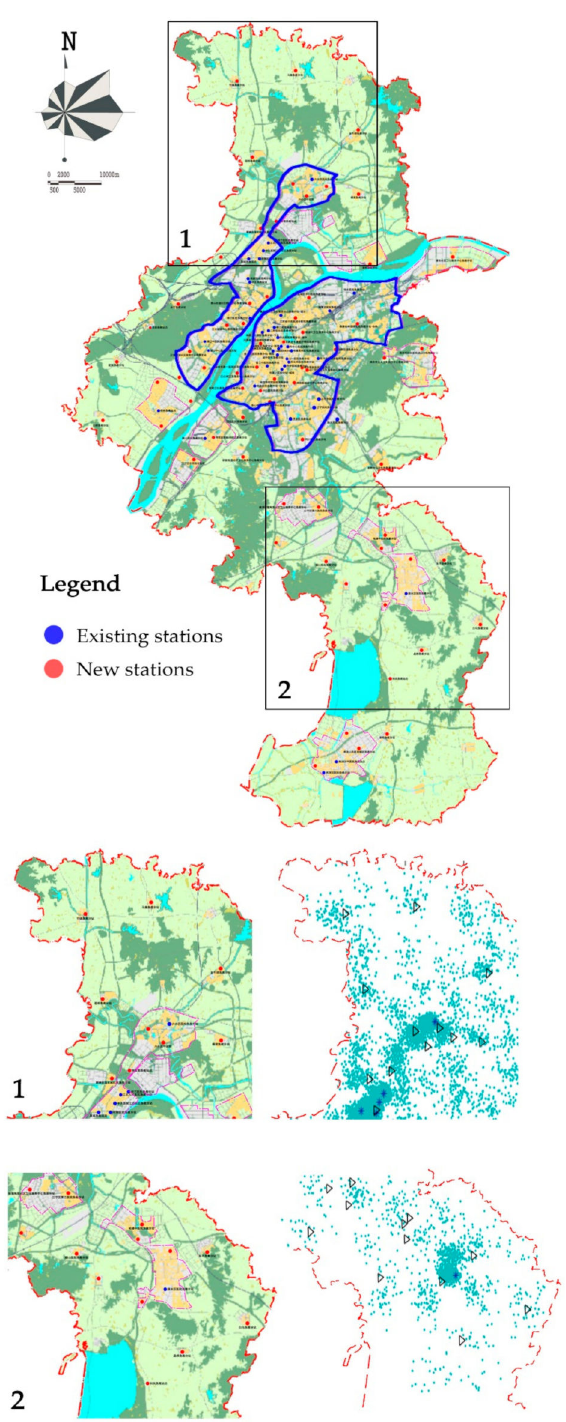
Figure 11. The final layout of first aid